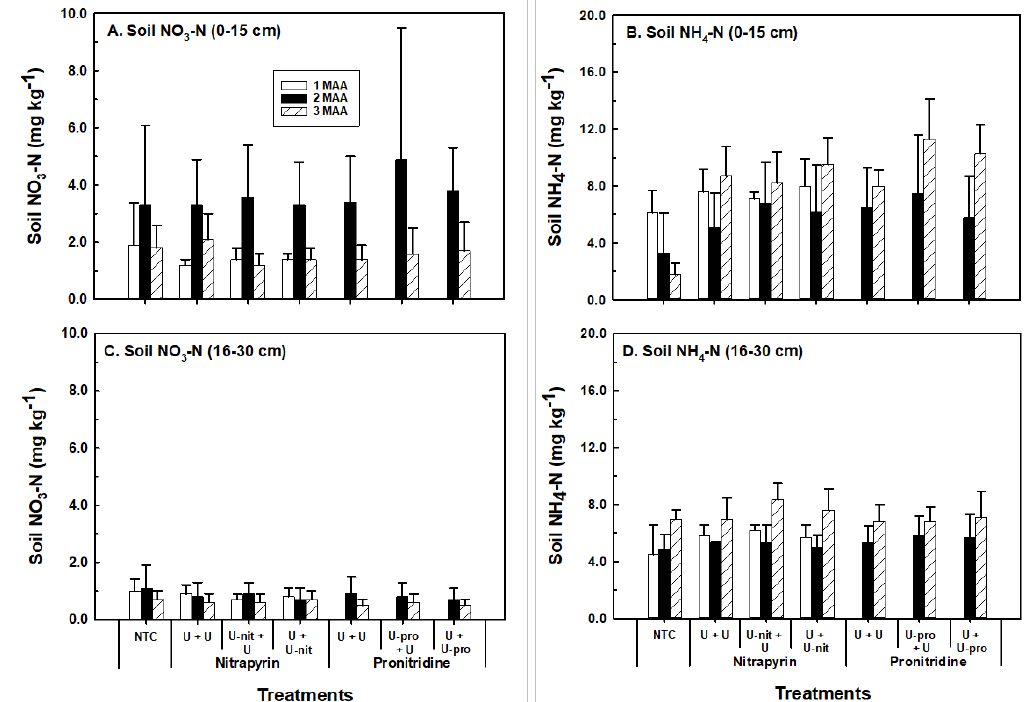
Figure 4. Soil test nitrate–nitrogen (NO 3 –N) concentration at 0–15 ( A ) cm and 16–30 ( C ) cm depths, and soil test ammonium–nitrogen (NH 4 –N) at 0–15 ( B ) cm and 16–30 ( D ) cm depths one, two, and three months after application (MAA) of a 40:60 split application of urea ammonium nitrate (U) totaling 112 kg N ha − 1 . Vertical error bars represent plus one standard deviation. Abbreviations: pro, pronitridine; nitr, nitrapyrin; NTC, non-treated control; U, urea ammonium nitrate. Application samples after one month were not taken for UAN at 112 kg N ha − 1